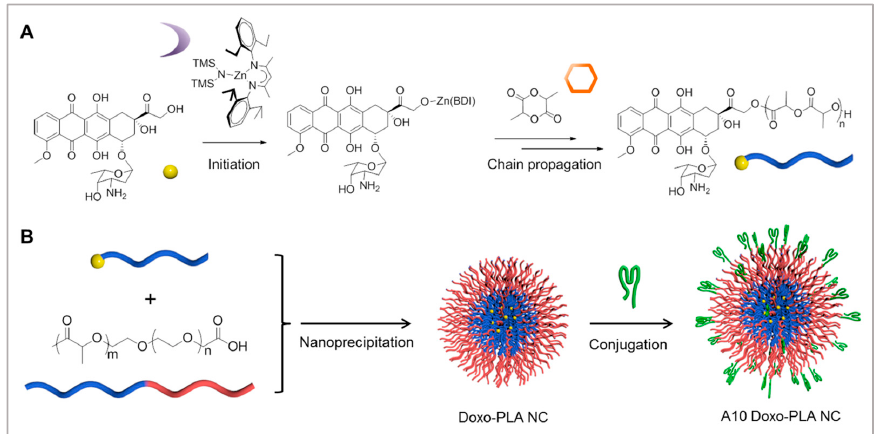
Figure 12. Preparation of A10 aptamer-functionalized doxorubicin-polylactide nanoconjugates (A10 Doxo-PLA NCs): ( A ) synthesis of Doxo-PLA polymer conjugate; ( B ) schematic illustration of formulating A10 Doxo-PLA NCs. Reprinted with permission from [136]. Copyright © 2015 American Chemical